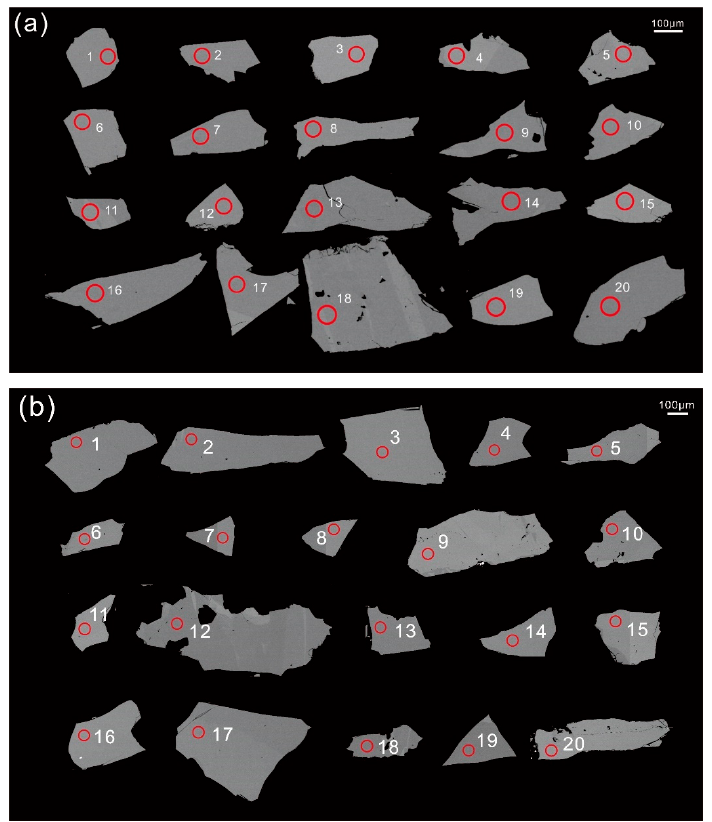
Figure 9. Backscattered electron images of the Mogok titanites MG-5 ( a ) and MG-6 ( b ). Red circles show positions for simultaneous LA-ICP-MS measurements of U–Pb ages. 206 Pb/ 238 U ages are in red.